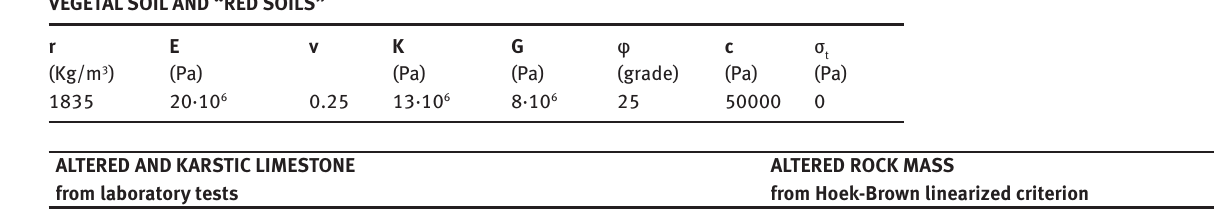
Table 2: Mechanical parameters of rocks and discontinuities (based on laboratory tests) of the geomechanical model. VEGETAL SOIL AND “RED